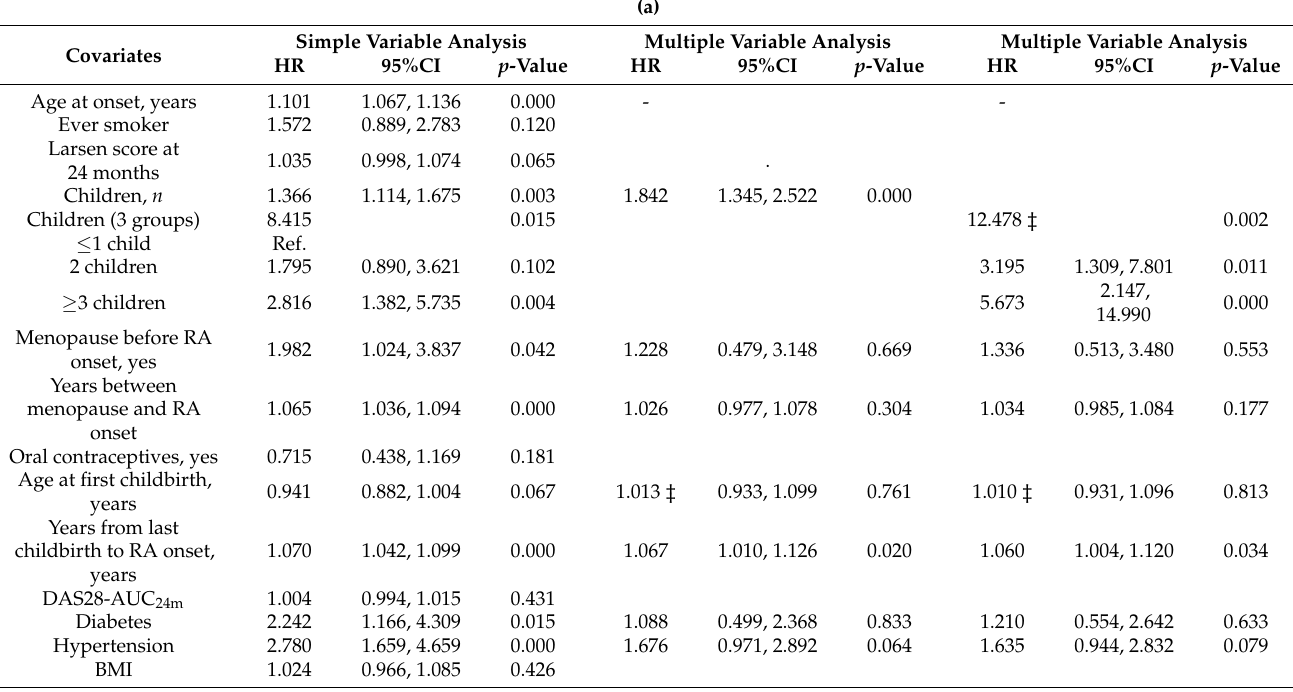
Table 4. (a). Simple and multiple variables in Cox proportional hazard regression analysis of CVE after RA onset as dependent variable ( n = 64) versus no CVD ( n = 700). Complete case analyses. (b). Simple and multiple variables in Cox proportional hazard regression analysis of CVE after RA onset as dependent variable ( n = 64) versus no CVD ( n = 700). Multiple imputation results.